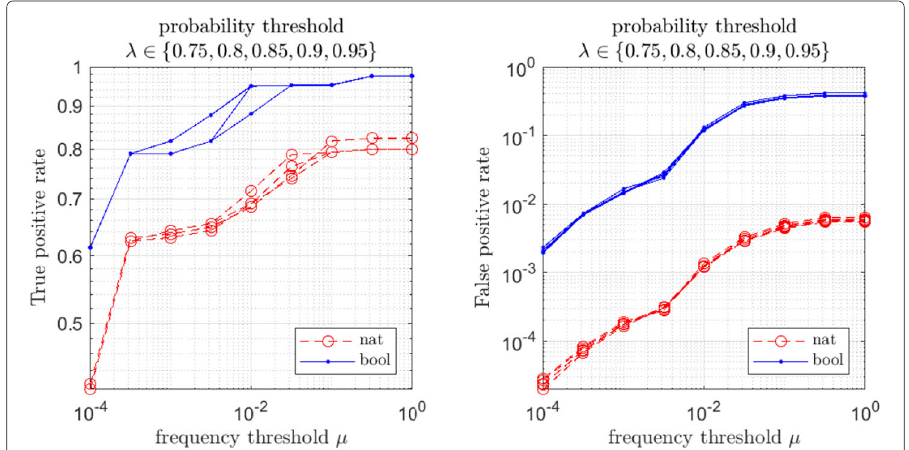
Fig. 3 True (left) and false (right) positive rates as defined in (10) for APT detections using the model of “Markov chain models for DCNs” section and as functions of a per-window frequency threshold μ and for varying flow probability thresholds λ